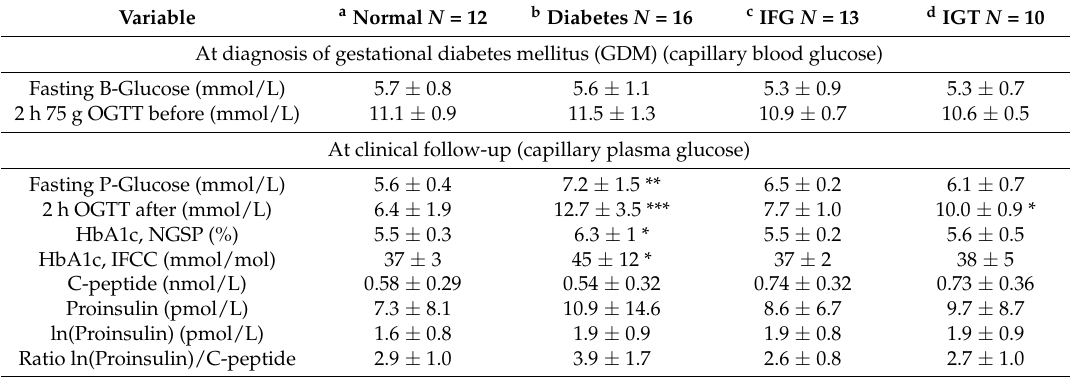
Table 2. Tests of glucose metabolism in 51 women at initial diagnosis of GDM and after 12 years. Follow-up divided into groups of a normal glucose tolerance N = 12, b diabetes mellitus N = 16, c impaired fasting glucose (IFG) N = 13, and d impaired glucose tolerance (IGT) N = 10. Glucose